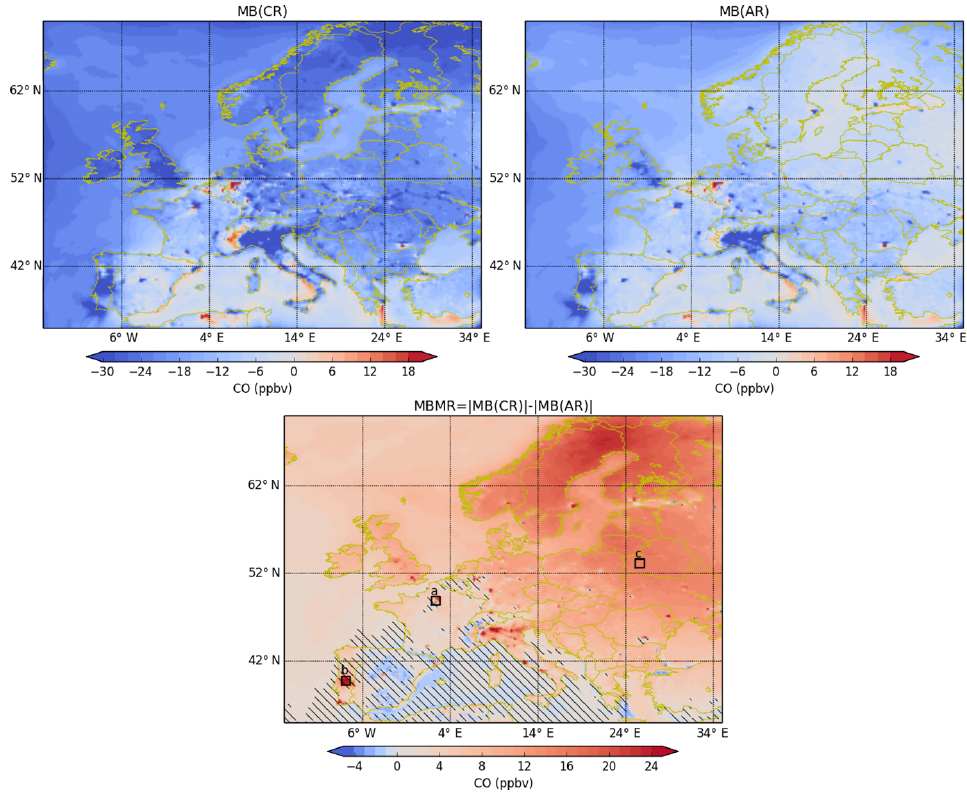
Figure 10. Mean bias reduction at the surface for CO, units of ppbv: Left top panel shows the CR mean bias with respect to the NR (CR- NR). Right top panel shows the AR mean bias with respect to the NR (AR-NR). Bottom panel shows the mean bias magnitude reduction (absolute value of the mean bias for CR minus the absolute value of the mean bias for AR). We average the data over northern summer 2003 (1 June–31 August). The labels show longitude in degrees ( x axis) and latitude in degrees ( y axis). The hatched area in the bottom panel shows where the mean bias plotted in this panel (MBMR) is not statistically significant at the 99% confidence level. The three squares in the bottom panel represent the locations for the three time series shown in Fig. 13. Red/blue colors indicate positive/negative values in the